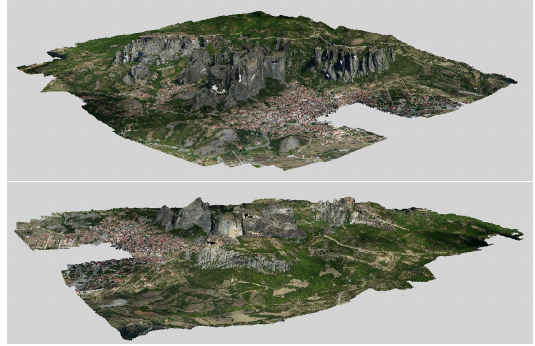
Figure 3. 3D views of the 3D textured model of the Meteora site The airborne LiDAR system provided independent point cloud data, i.e., one for each channel (green and near-infrared). The point clouds were of high-density (~ 80 points/m 2 ) and large volume. Thus, they were organized into subsets